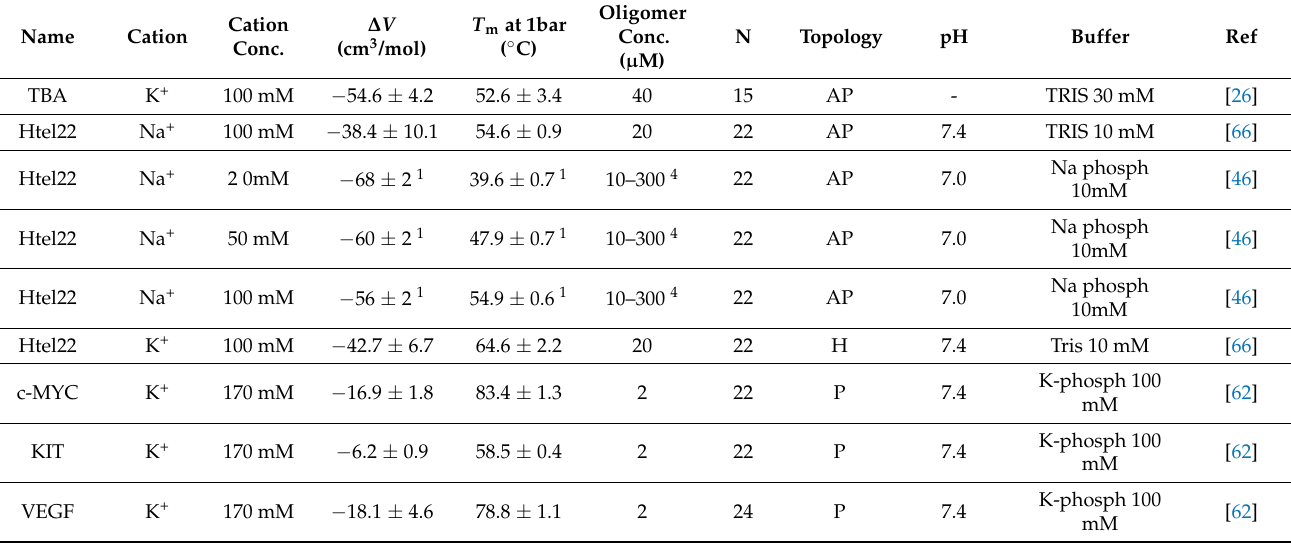
Table 2. The unfolding volumes and temperatures of DNA GQs, and the corresponding experi-mental